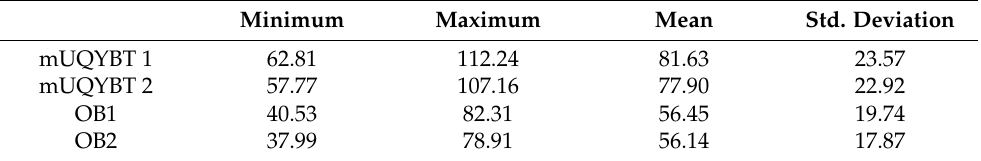
Table 8. Reproducibility of mUQYBT and OB in week 1 and week 2.